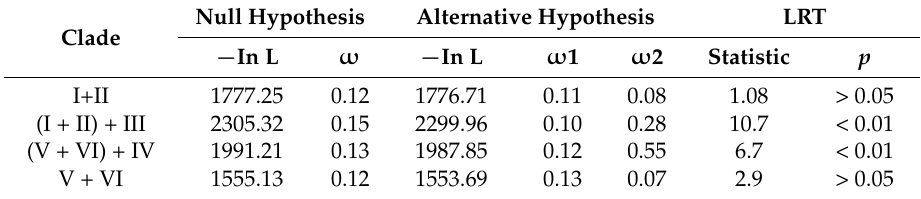
Table 3. Likelihood-ratio test (LRT) statistic and parameters from Branch model of PAML. Clade